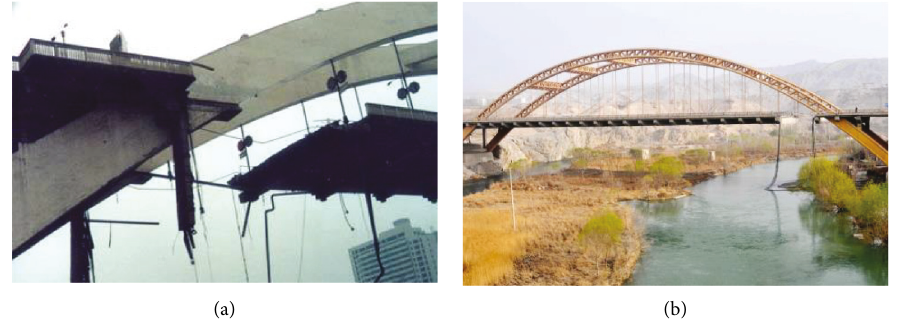
Figure 1: Damage forms of different bridge decks.